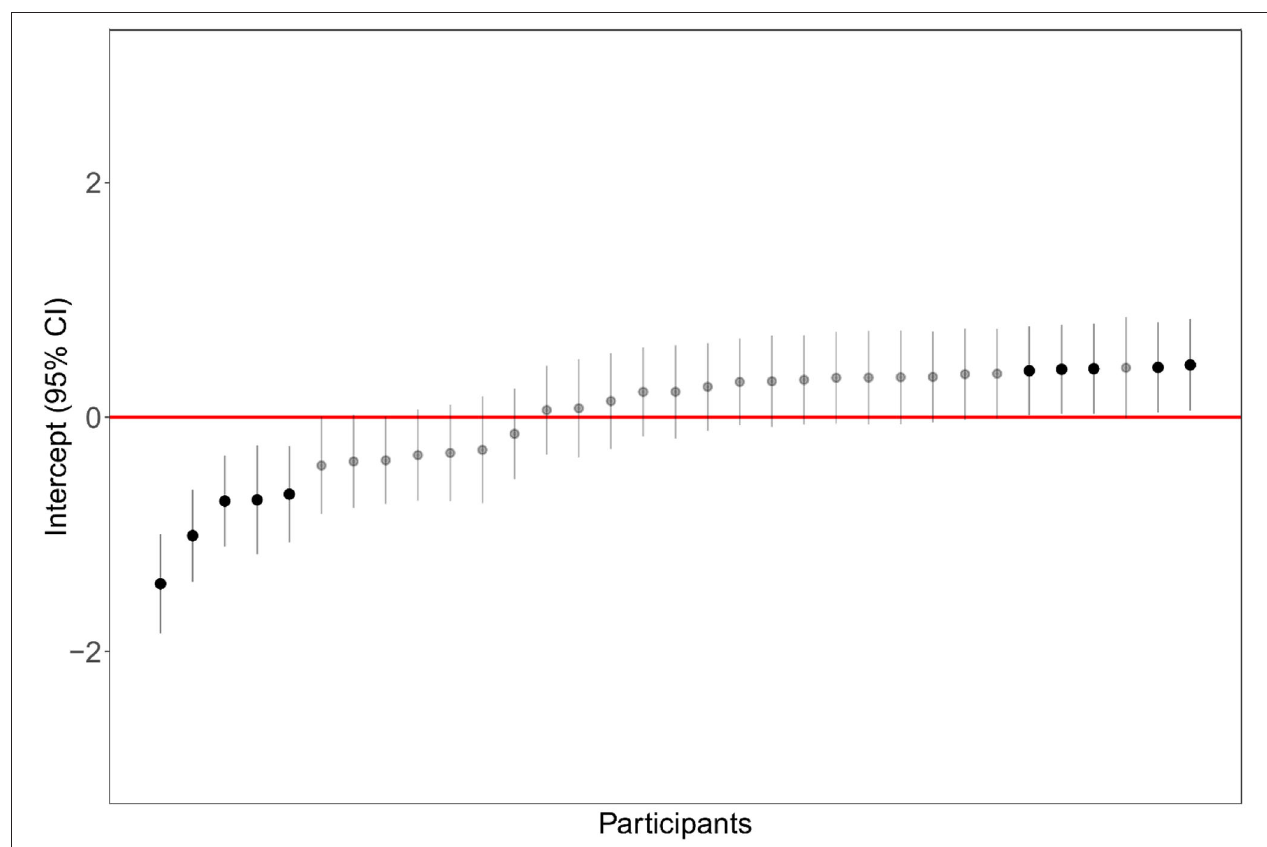
FIGURE 5 | Distribution of participants’ intercept (random effect) in the linear mixed model testing number of fixations as a function of aggregation level and aggregation type.